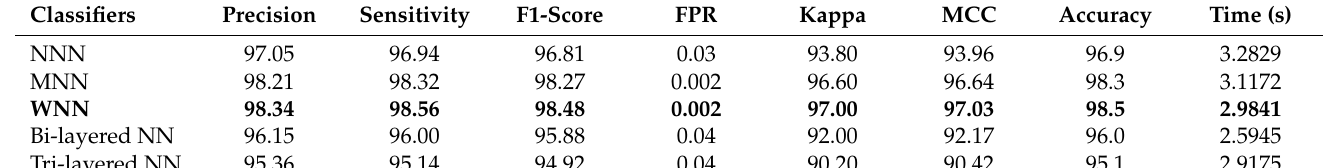
Table 5. Proposed fusion results on COVID-19 Patients Lungs X-ray dataset.